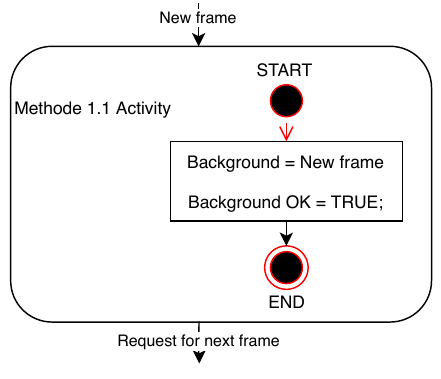
Figure 3. Diagram of Method 1.1 activity.